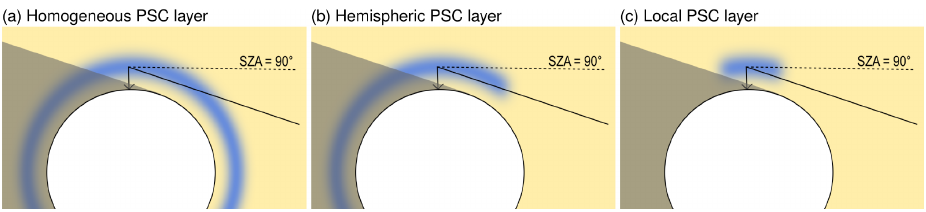
Figure 1. Scheme of different geometric configurations. The shadow indicates the area which cannot directly be “hit” by photons from the sun for SZA > 90 ◦ . The “standard” configuration refers to the homogeneous PSC layer (a) . The effect of different other configurations is detailed at the end of Sect. 3.1.